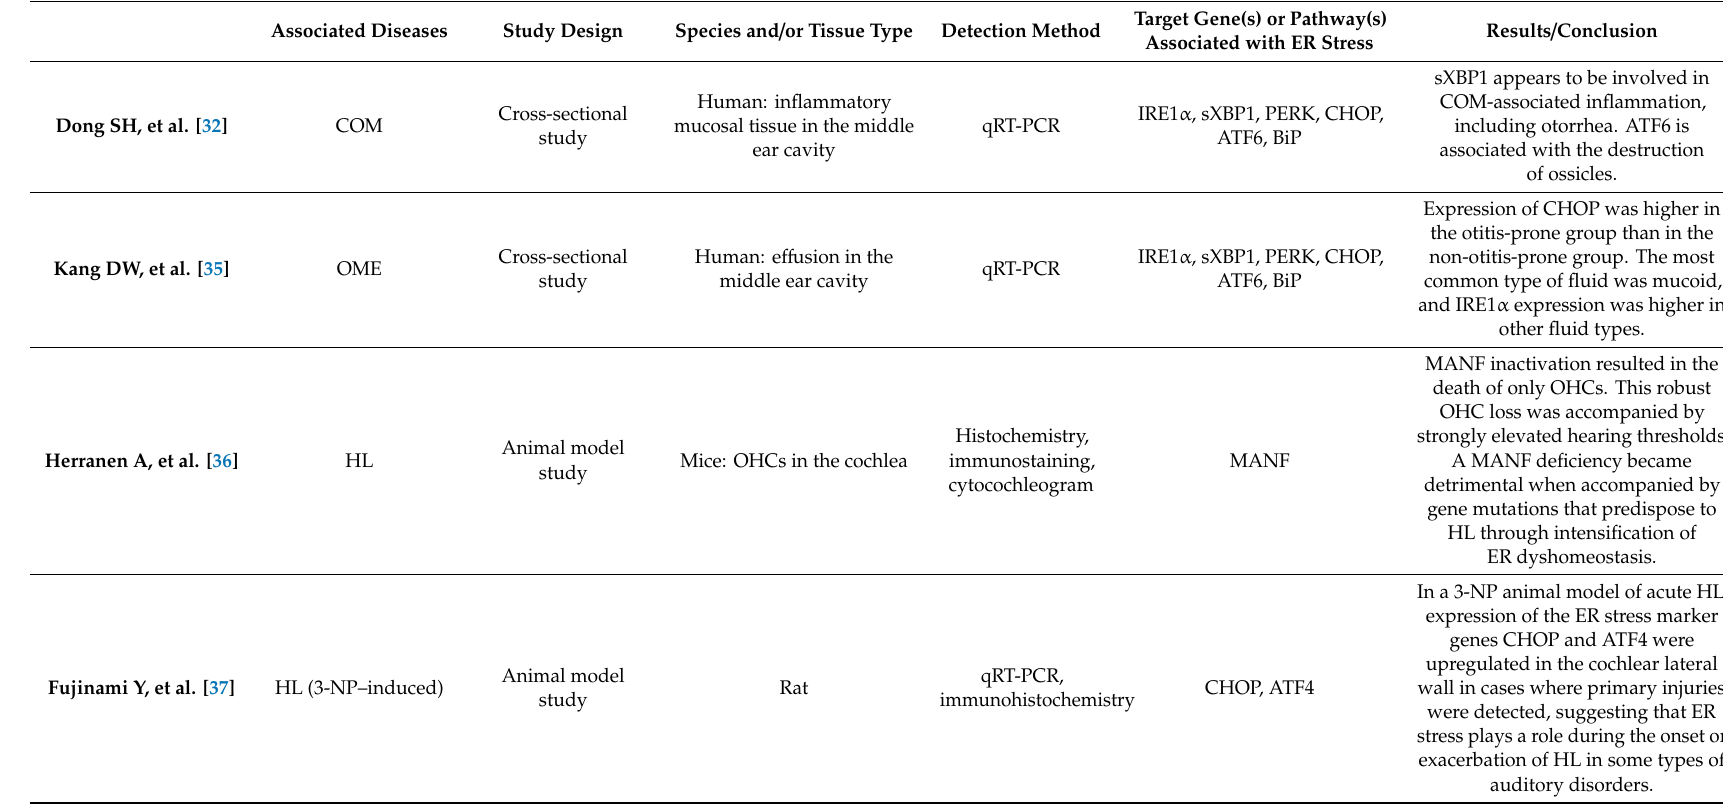
Table 1. Studies assessing the association between otologic diseases and ER